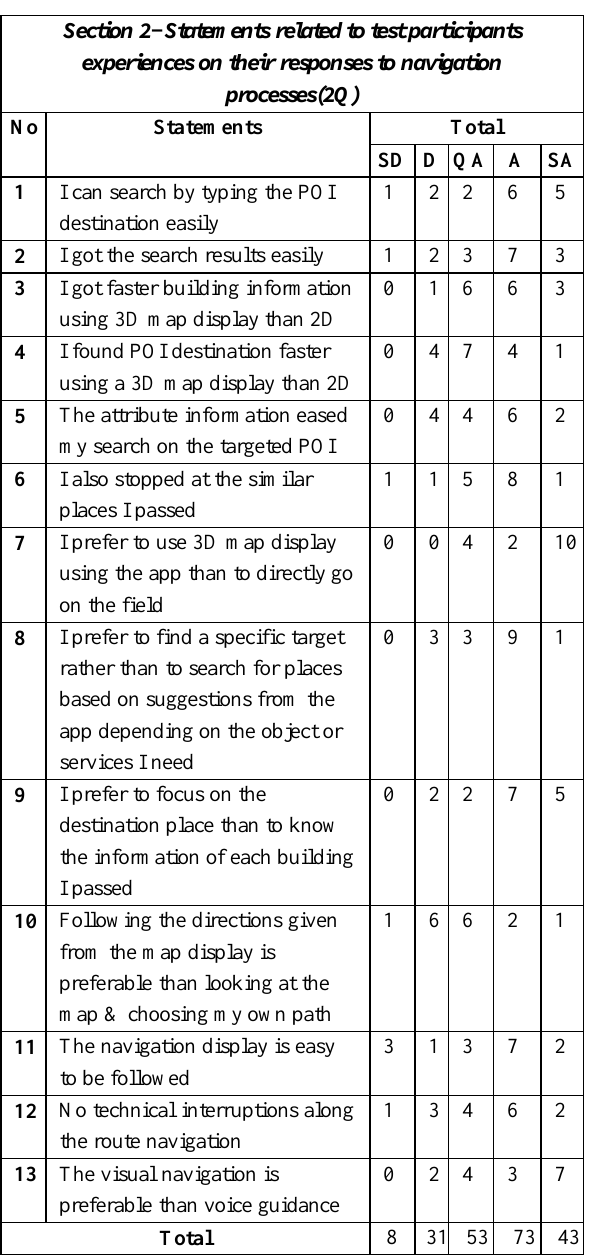
Table 4. Statements and responses related to Section